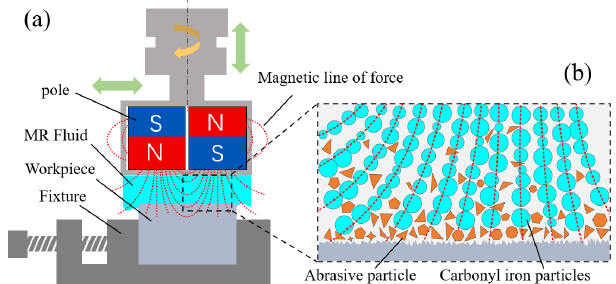
Figure 1. Principle of magnetorheological